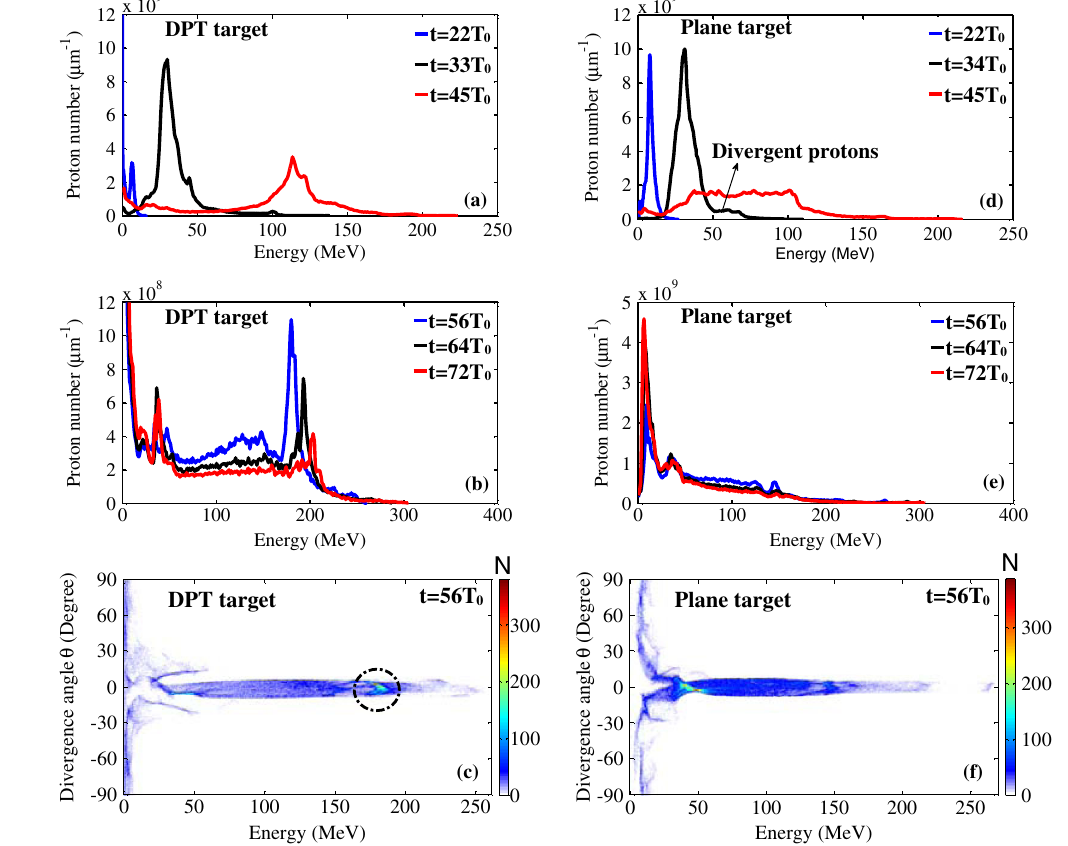
FIG. 4. Parts (a) and (d) plot the energy spectra for protons located within the central region ( 29 (cid:1) 0 < y < 31 (cid:1) 0 ) of the DPTand plane target cases, respectively, at the corresponding time steps as in Figs. 3(b)–3(d) and 3(f)–3(h). Parts (b) and (e) plot the energy spectra at later time for protons located within the same transverse region as above for the DPTand plane target cases, respectively. The reduction of particle number in the peaks in (b) with time is due to the fact that some energetic protons move out of the region with 29 (cid:1) 0 < y < 31 (cid:1) 0 at later time. Parts (c) and (f) show the divergence angle and kinetic energy distribution of the protons of the central region of the DPTand plane targets at t ¼ 56T 0 , respectively. The initial normalized peak laser amplitude is a ¼ 58 and the target density n ¼ 400 n c